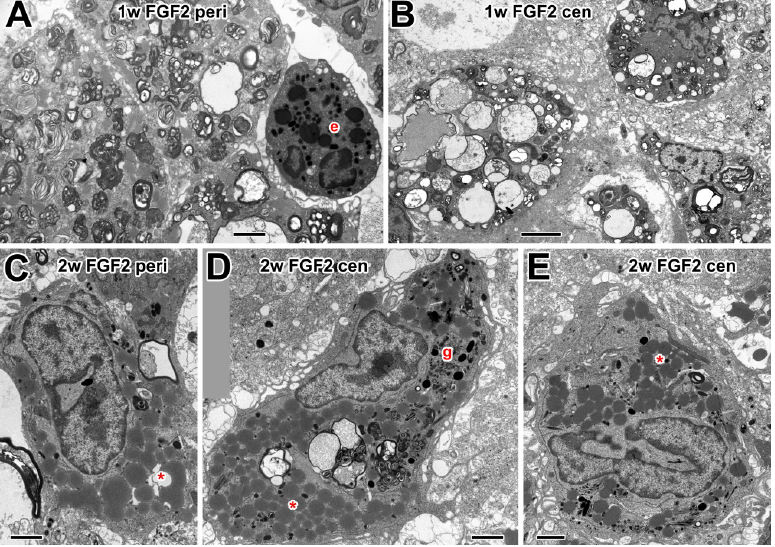
Fig 7. Electron microscopy of macrophages in FGF-2-treated nerve. (A) Peripheral macrophages at 1w, containing multilamellar bodies. Also present is a possible granulocyte, with a bilobed nucleus and dark granules (e). (B) Macrophages in the central optic nerve at 1w, containing vacuoles with axonal debris. (C) Peripheral nerve at two weeks showing macrophage with lipid inclusions (asterisk). (D) Large, centrally located macrophage at 2 w with multilamellar bodies, axonal debris and lipid inclusions (asterisks). Around its nucleus are numerous dark granules (g). (E) A similar large central macrophage with a highly indented nucleus and lipid inclusions (asterisk). Scale bar: 2 μ